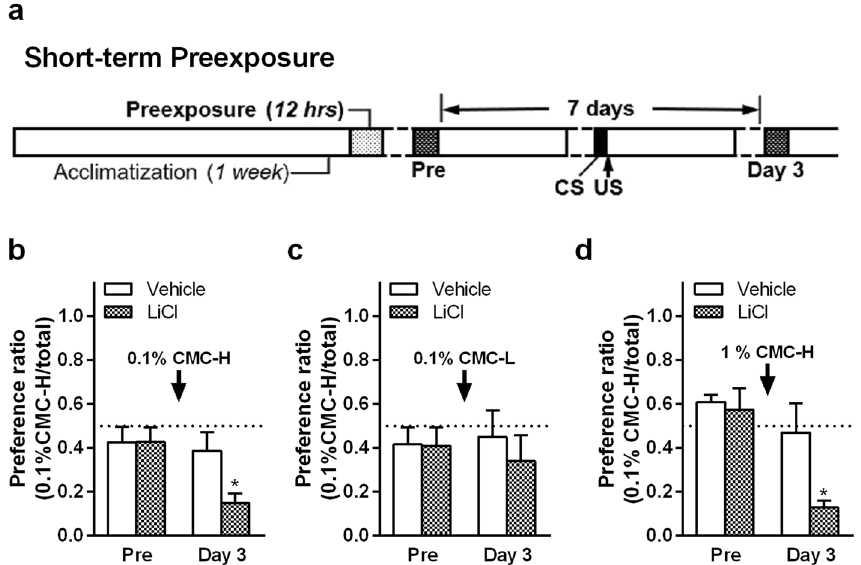
Figure 4. Conditioned aversion tests to 0.1% low- or high-viscosity carboxymethyl cellulose (CMC)-containing fluids 3 days after lithium chloride (LiCl) injection (unconditioned stimulus [US]) following ingestion of a viscous fluid (conditioned stimulus [CS], indicated by an arrow in each graph). CMC-L, low-viscosity CMC fluid; CMC-H, high-viscosity CMC fluid. Mean ± standard error of the mean. ( a ) Short-term pre-exposure (approximately half a day) to CMC solutions was carried out before conditioning. A pre-exposure procedure was performed to acquire safe learning of the CMC taste in rats. Following a short pre-exposure to 0.1% CMC-H with baseline value measurements, the preference ratio in water and 0.1% CMC-H after LiCl injection following ingestion of 0.1% CMC-H ( b ) or 0.1% CMC-L ( c ) or 1% CMC-H ( d ) as CS (each group, n = 5). *, P < 0.05 against vehicle on the same tested day by unpaired two-tailed Student’s t test.